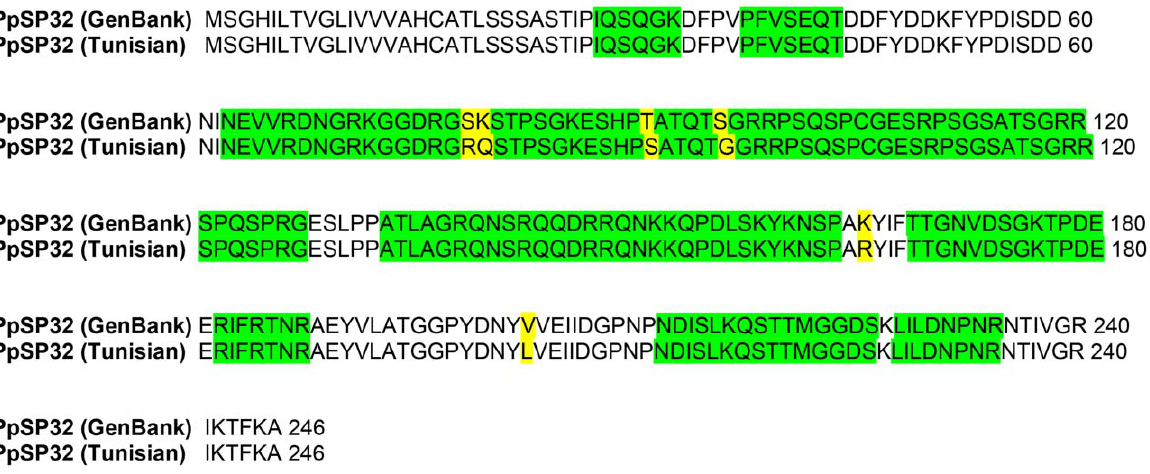
Figure 3. Comparison of predicted B cell epitope between PpSP32 (GenBank AF335490.1) and PpSP32 (Tunisian strain). Yellow shaded amino acids indicate lack of identity. Green shaded amino acids indicate a strong B cell epitope predicted by the bcepred software.